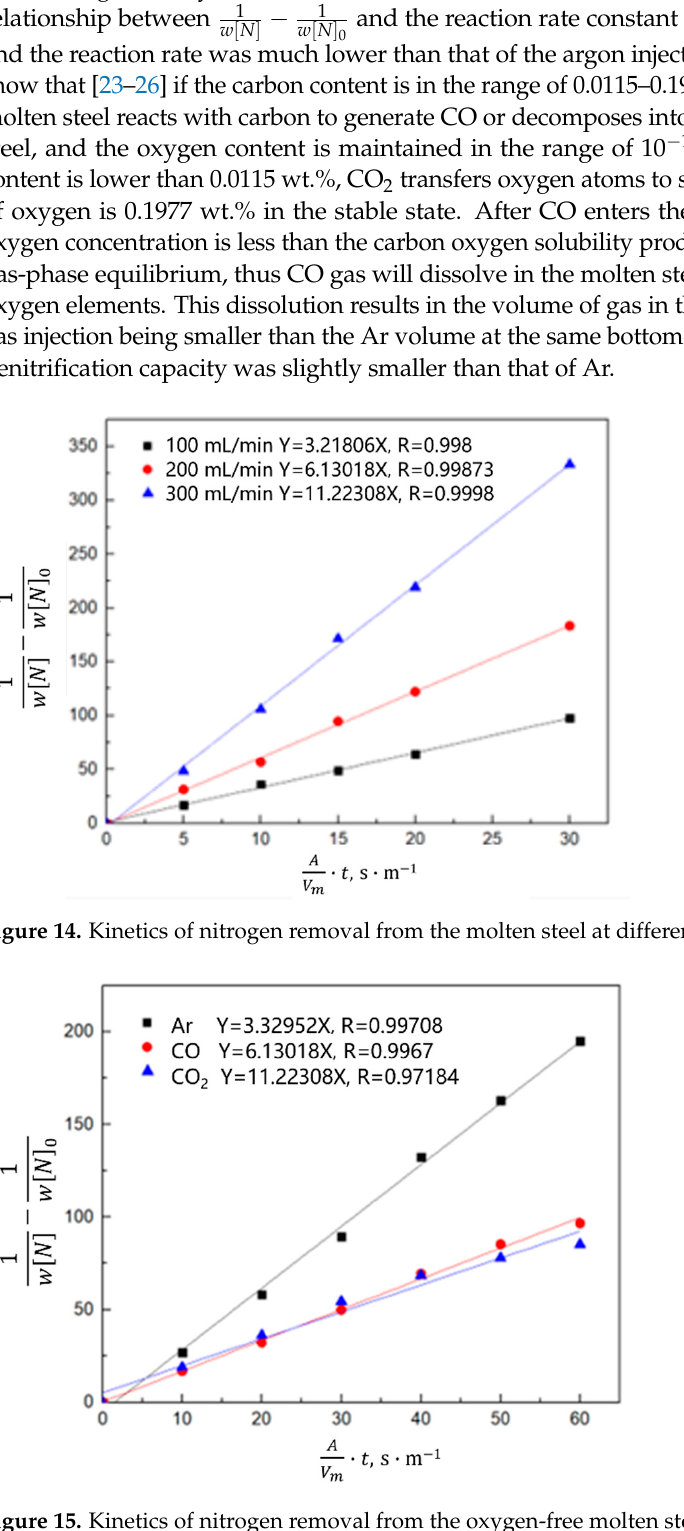
Figure 15. Kinetics of nitrogen removal from the oxygen-free molten steel with different gases.